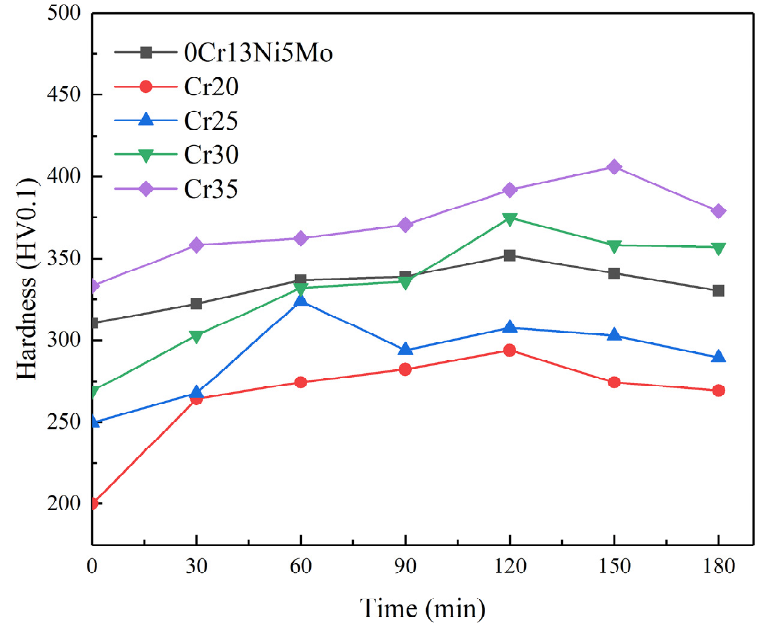
Figure 13. The hardness of 0Cr13Ni5Mo steel and the CoCr x FeMnNi HEA coatings after CE tests in distilled water.